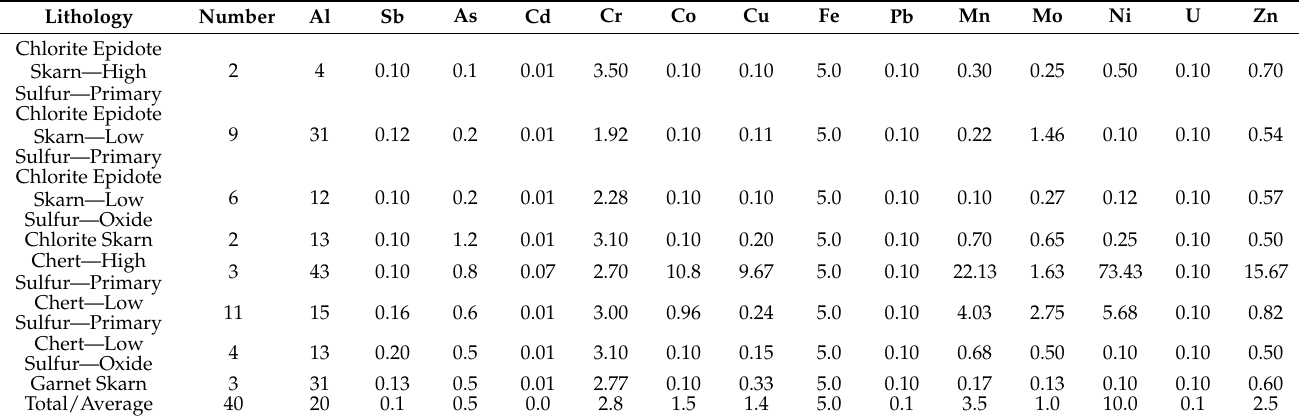
Table 7. Summary of hydrogen peroxide leach results for the waste rock samples. All values in